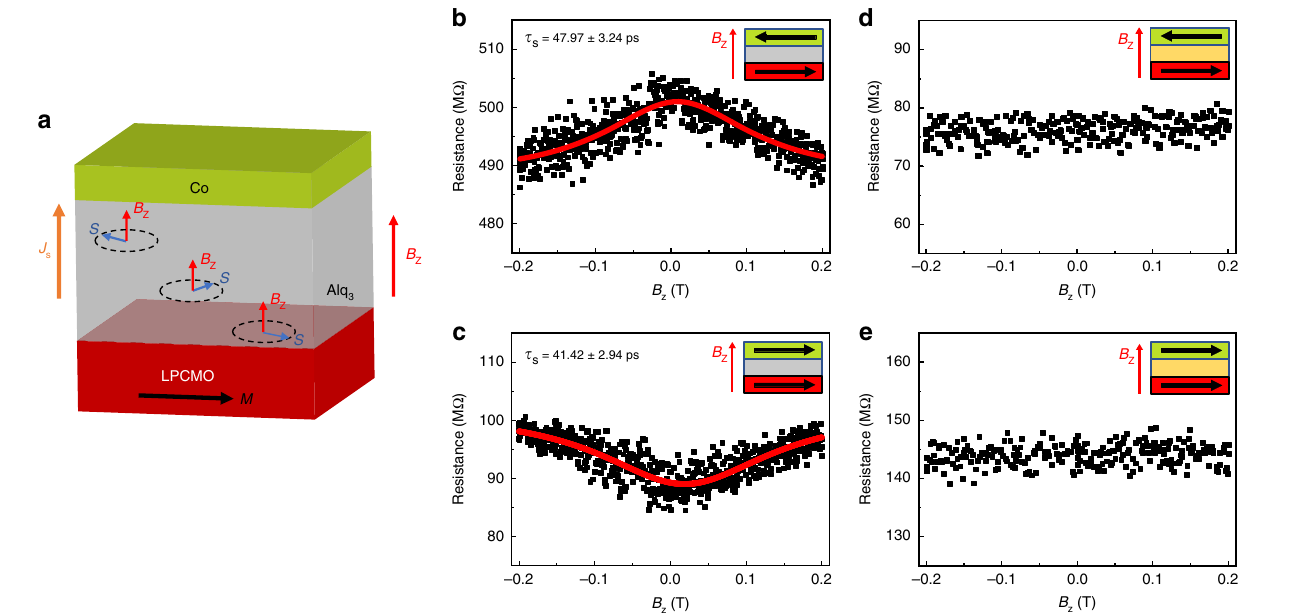
Fig. 3 Signature of Hanle response in the LPCMO-OSV device. a Schematic illustrated Hanle effect in the LPCMO-OSV device. b , c Obtained electrical Hanle effect in the LPCMO-OSV device when a perpendicular magnetic fi eld ( B z ) is applied to the device in the antiparallel ( b ) and parallel magnetic con fi guration ( c ), respectively. The red solid lines show the fi tted plots using Eq. (1), from which the spin relaxation time, τ s = 48.0 ± 3.2 ps and 41.4 ± 2.9 ps is extracted from the antiparallel and parallel con fi guration, respectively. The insets show the direction of magnetization of the two FM electrodes in two magnetic con fi gurations. d , e No Hanle curve is observed in the magnetic tunnel junction device using the LPCMO electrode (LPCMO/Al 2 O 3 /Co) in two magnetic con fi gurations, respectively. The Hanle measurements were performed at T = 10